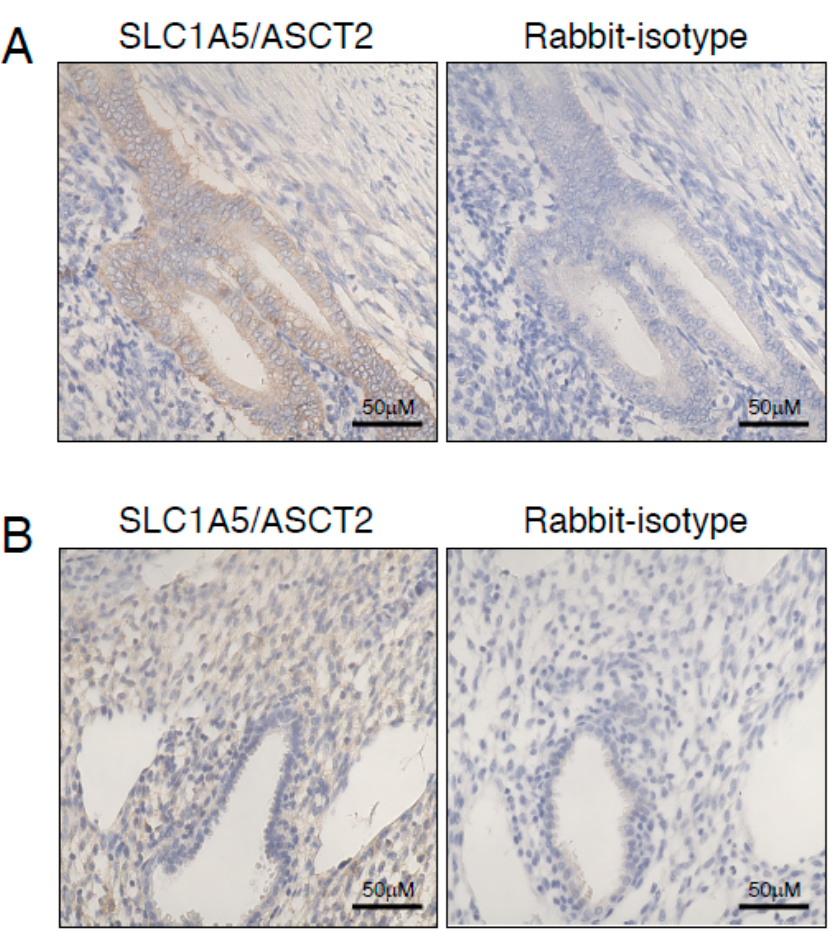
Figure 1. Expression of SLC1A5/ASCT2 in endometrial and decidual tissues. Immunohistochemical staining was performed for SLC1A5 using endometrial tissues from non-pregnant women in the follicular phase ( A ) and a sample of a placenta with decidual tissues obtained from a 7-week pregnancy ( B ). Scale bars are as indicated.